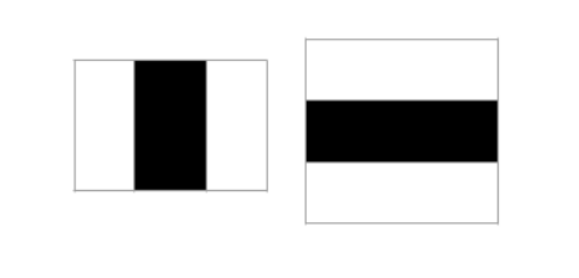
Figure 3: 3 Rectangle